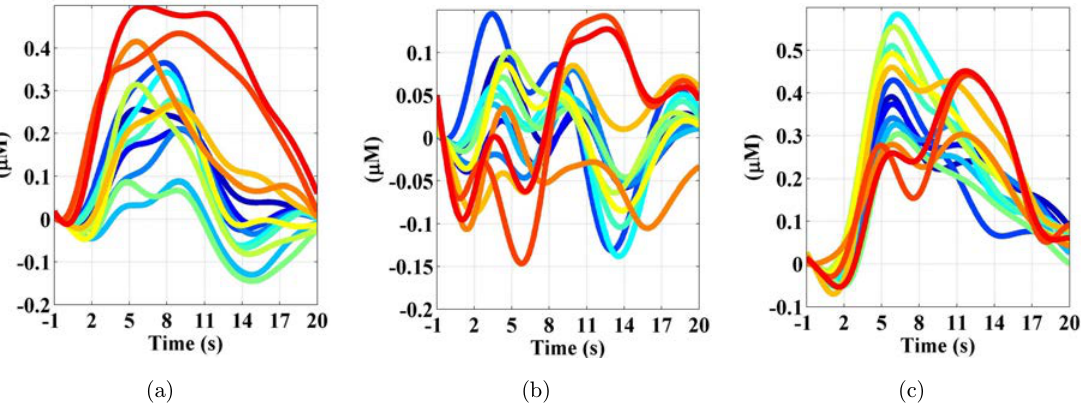
Fig. 2. Grand-averaged HbO data across all subjects associated with: (a) the transcoding strategy, (b) the code-mixing strategy, and (c) the transphrasing strategy for all 14